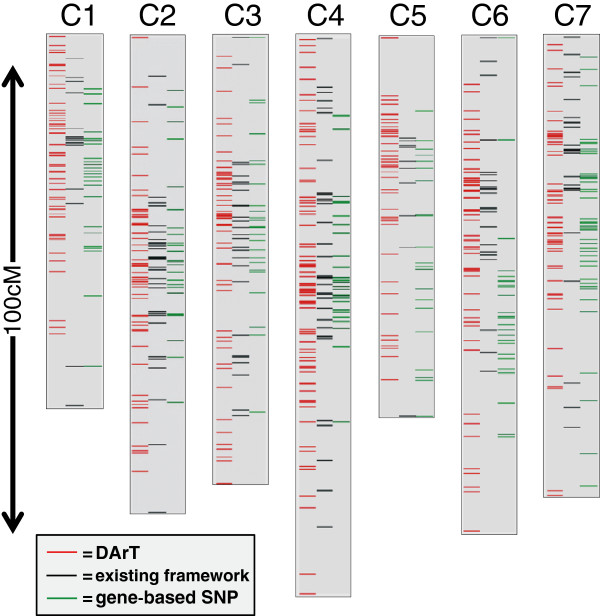
L. perenne genetic map. Genetic map of the L. perenne F2 mapping population illustrating the relative distributions of marker types over the 7 linkage groups (C1-C7). For each linkage group, column 1 contains the DArT marker positions, column 2 framework marker positions excluding gene-based SNPs and column 3 the gene-based SNP marker positions.